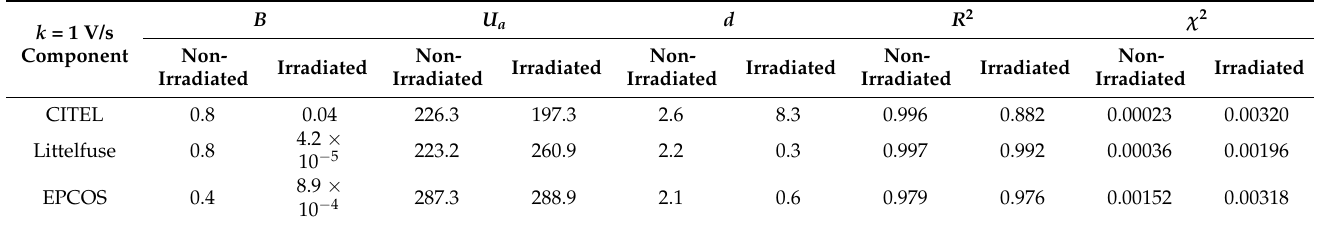
Figure 11. Cumulative distribution functions of CITEL, Littelfuse and EPCOS GFSAs, respectively, in the presence of gamma radiation for increase voltage rates k = 1 V/s. Table 3. Weibull distribution parameters, R 2 and χ 2 coefficients for CITEL, Littelfuse and EPCOS GFSAs without and in the presence of gamma